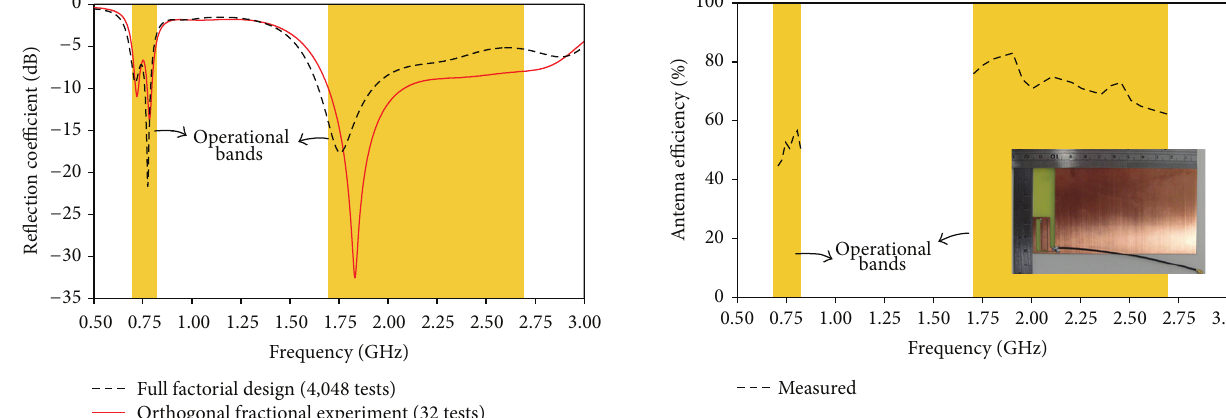
Figure 9: Measured antenna efficiencies of the optimized antenna structure. Shown in the inset is the photograph of the fabricated